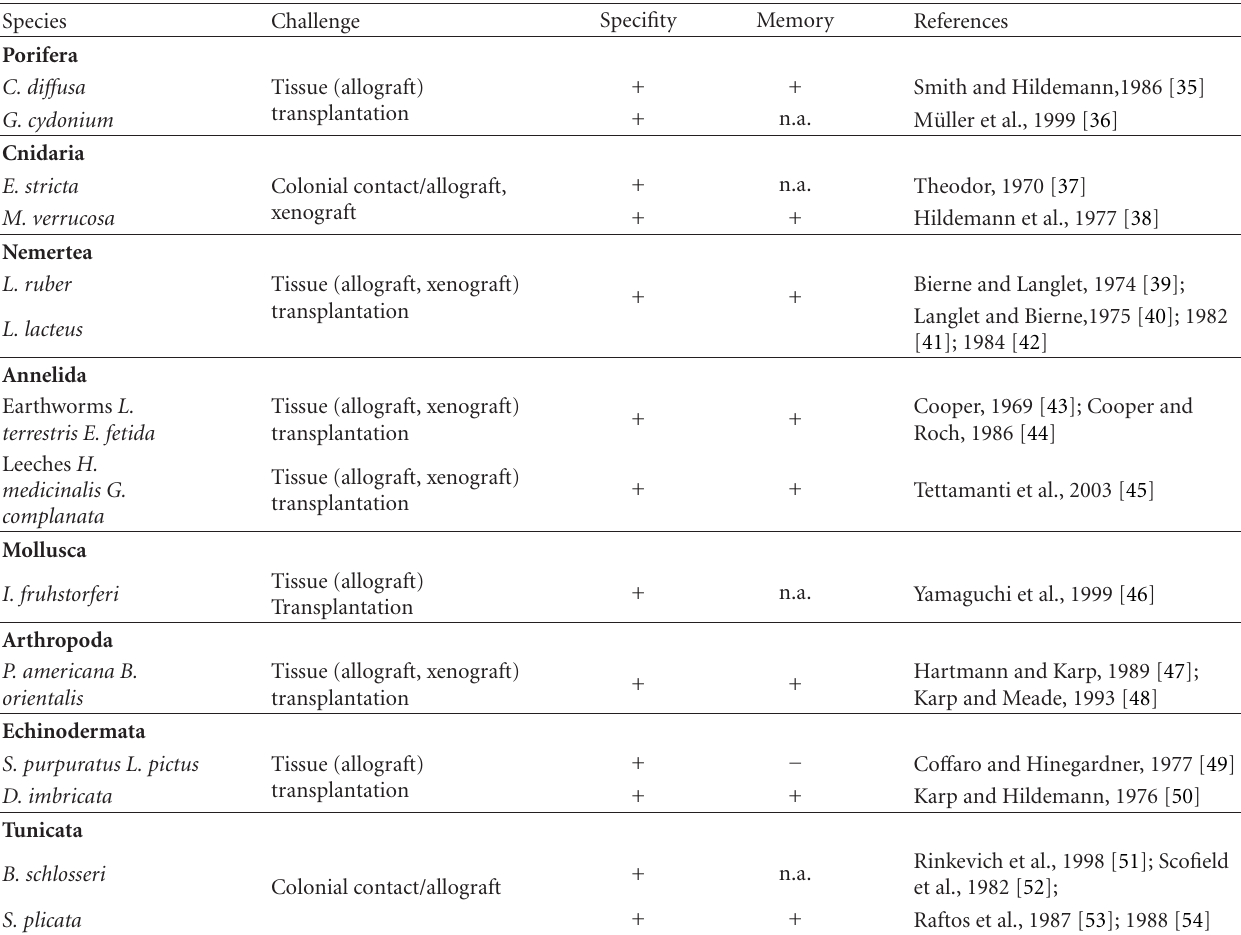
Table 1: Invertebrates exhibiting induction, specificity, and/or immunological memory in the nonpathogenic context of first and second challenges with transplants (n.a.: not